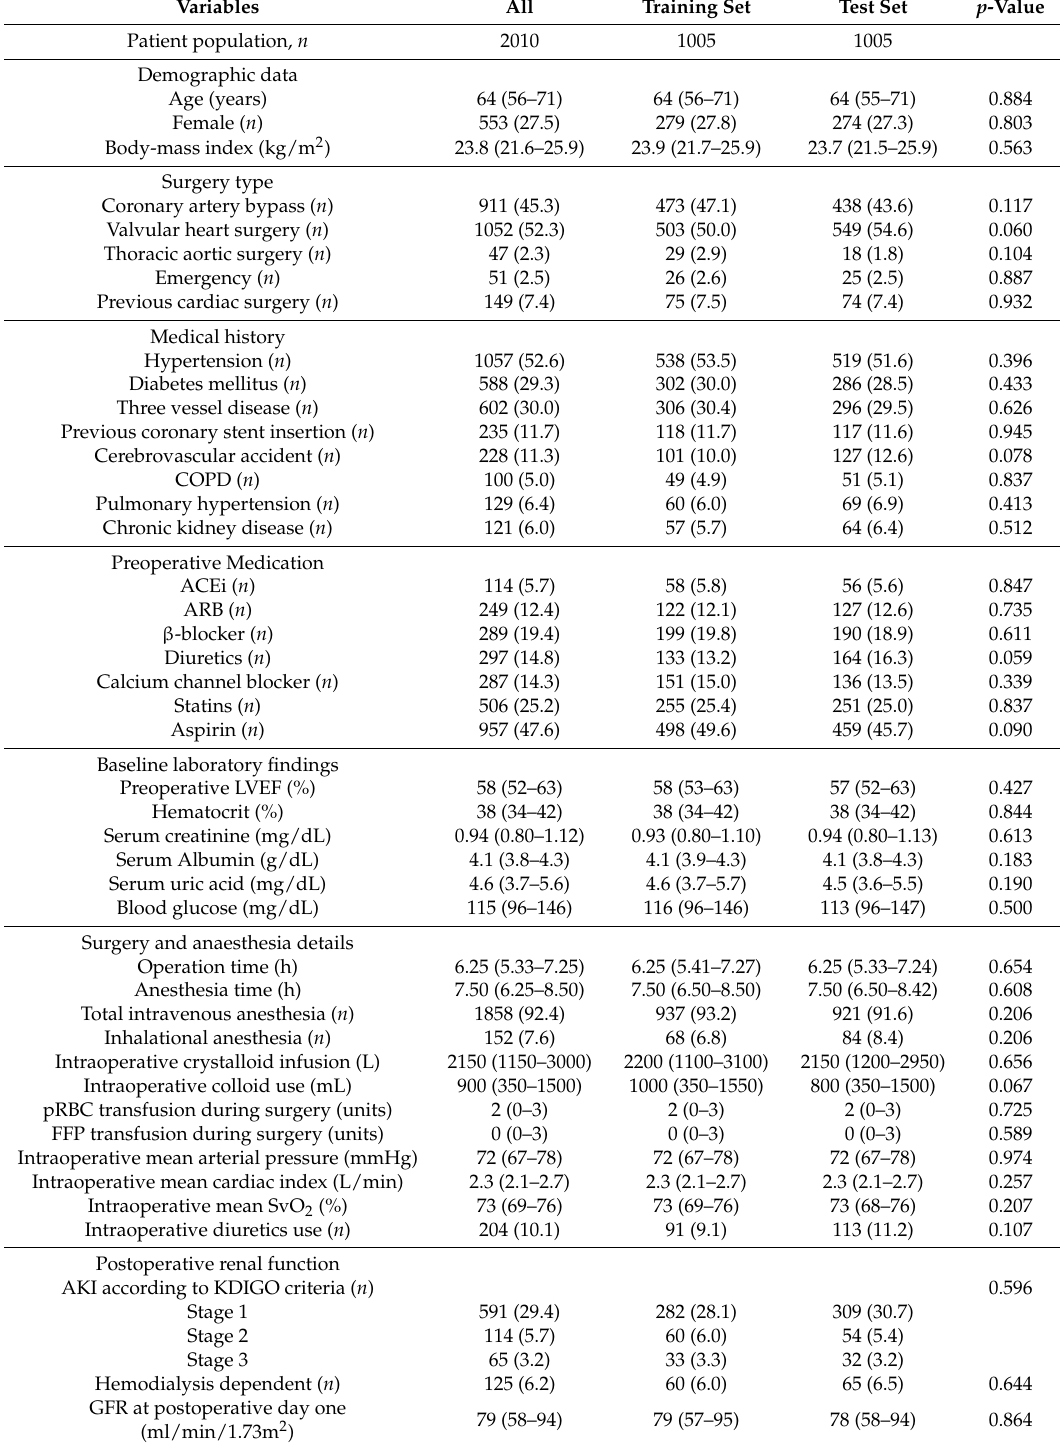
Table 1. Patient characteristics and postoperative renal function in the